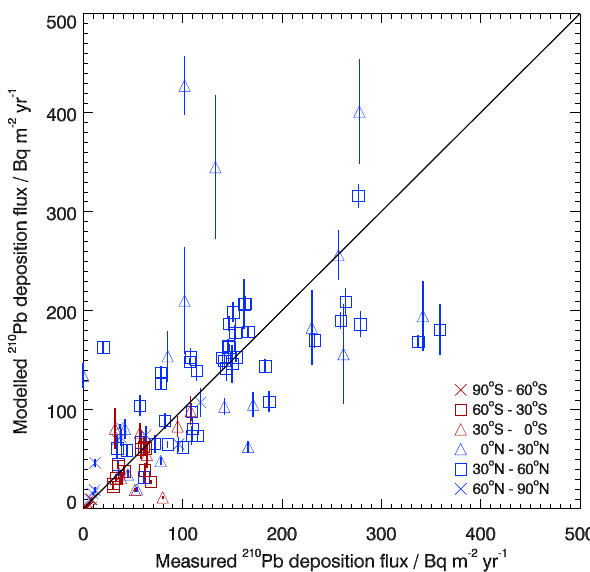
Fig. 7. Scatter plot of the modelled and measured 210 Pb annual deposition fluxes in units of Bqm − 2 yr − 1 , where 1.0 Bqm − 2 yr − 1 is equivalent to 8.87 × 10 22 kgm − 2 yr − 1 . Northern Hemisphere points are shown in blue and Southern Hemisphere points are shown in red. The vertical whiskers represent ± 1 standard deviation of the modelled annual mean deposition fluxes at each location. Measurements are taken from Preiss and Genthon (1997).